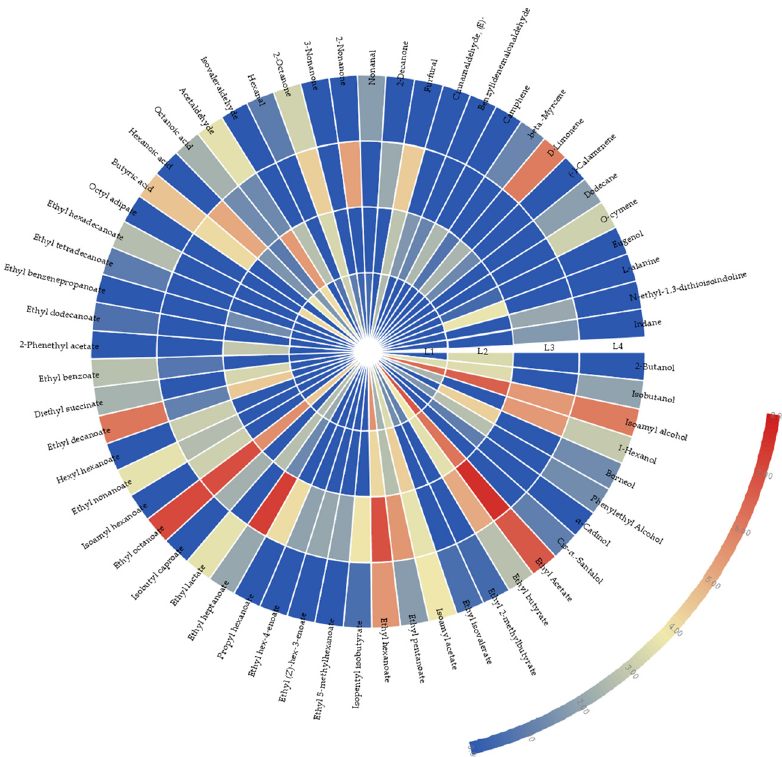
Figure 3: Heat map analysis of aroma compounds in four functional